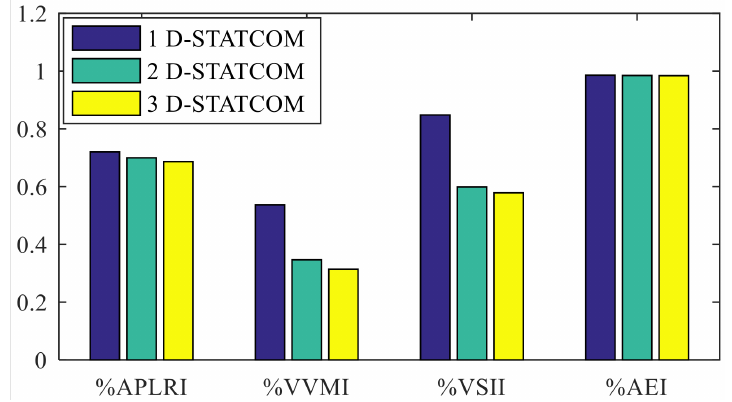
Figure 13. Comparison of performance indices for OADS in 33-bus PDN.